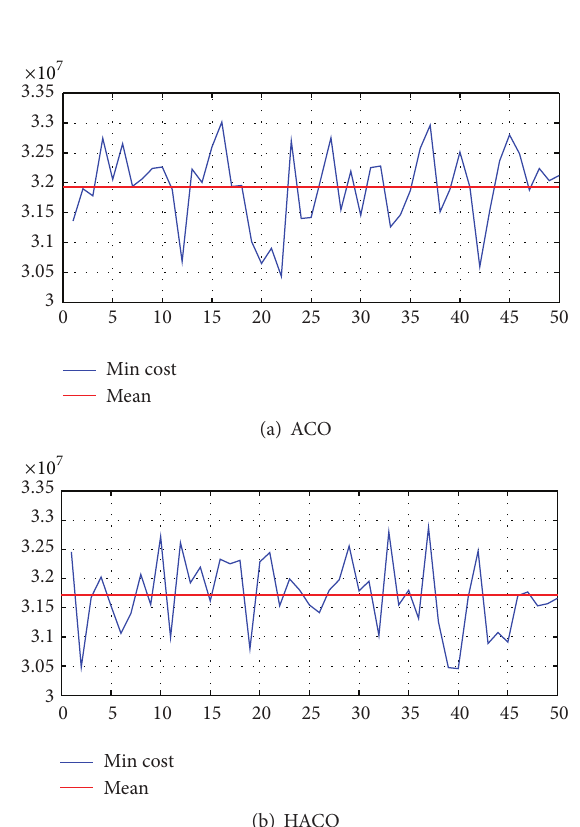
Figure 4: The fluctuation curve of optimal objective function value.